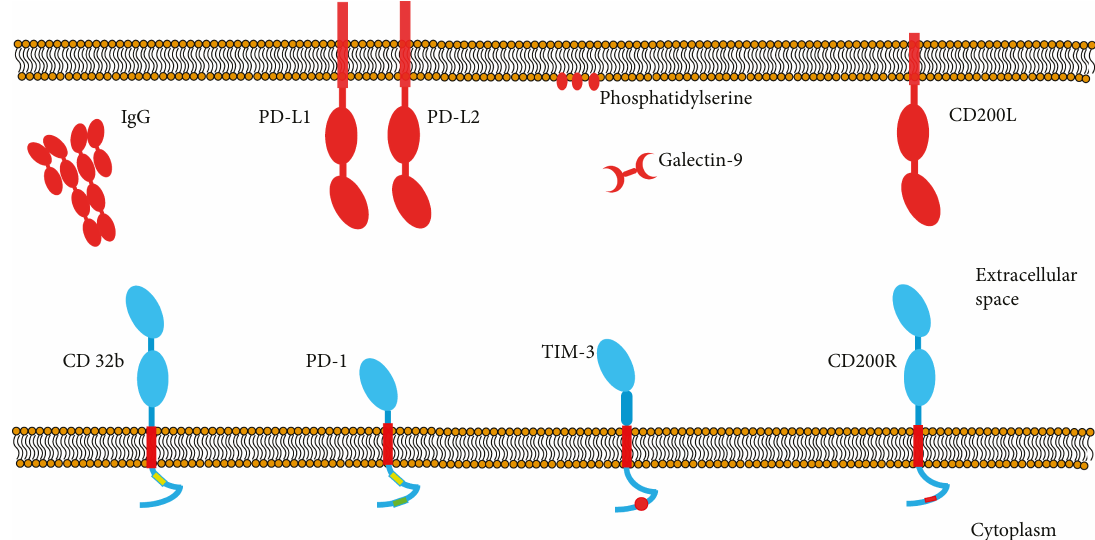
Figure 1: Schematic representation of the structures of inhibitory receptors. All receptors belong to the superfamily of immunoglobulins. They have a single transmembrane portion and an intracellular tail, through which they associate with proteins or e ff ector enzymes. The immunoglobulin domains are represented as blue ovals for receptors and red ovals for